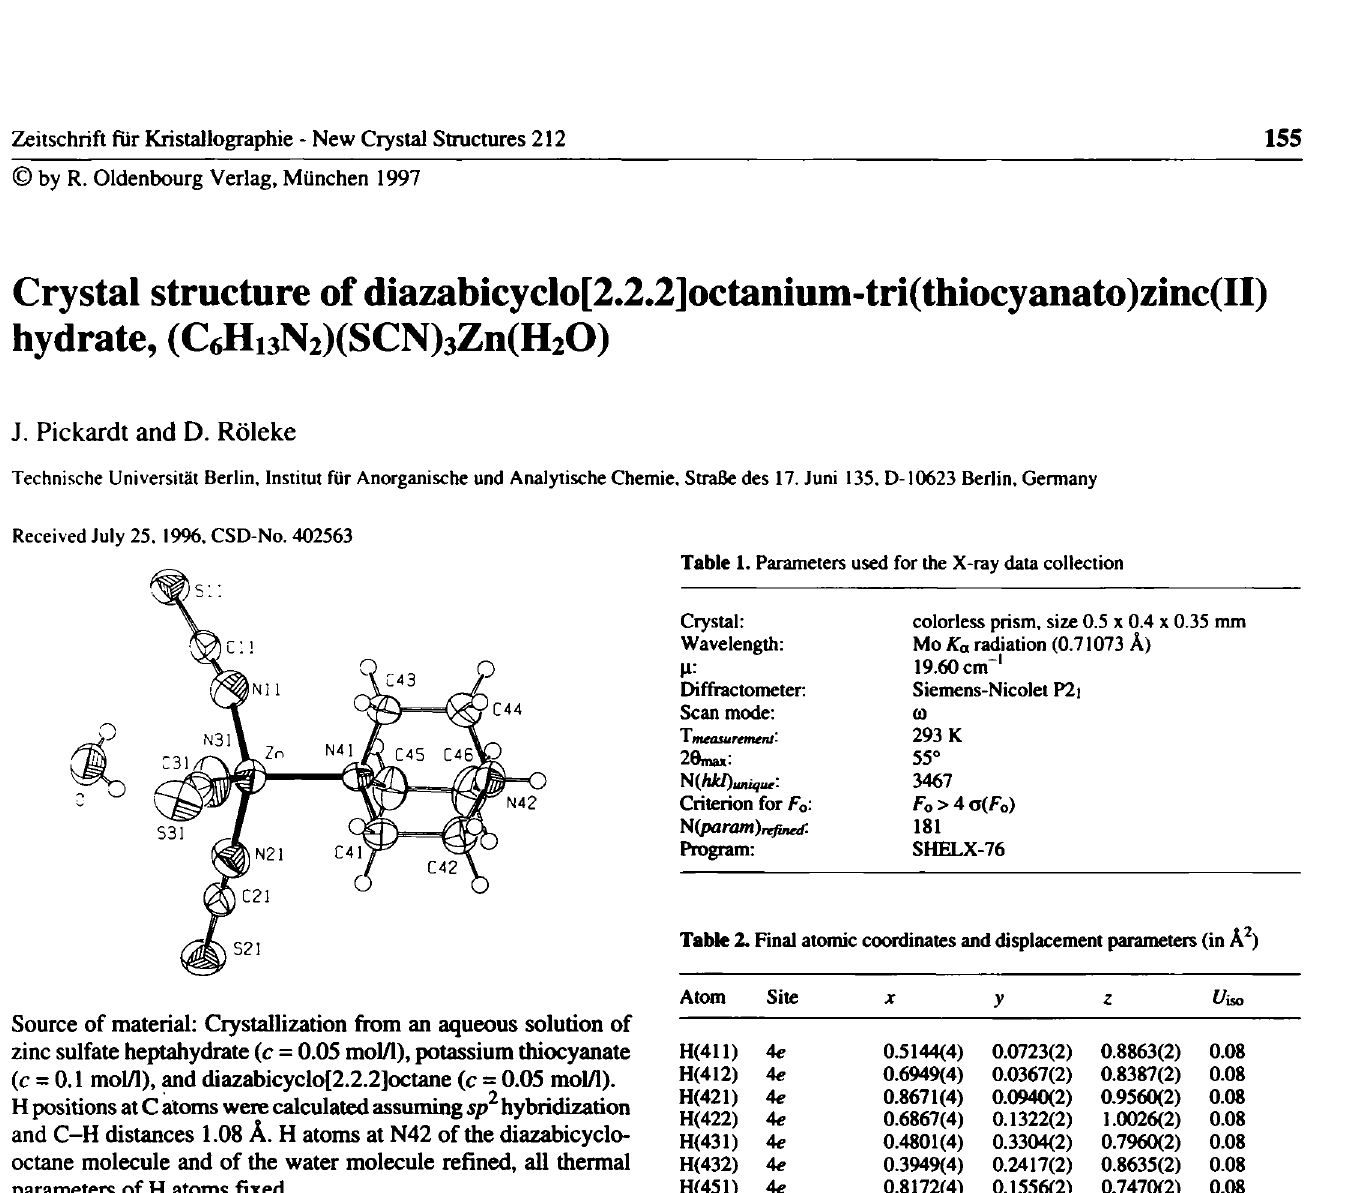
Table 3. Final atomic coordinates and displacement parameters (in Â 2 )